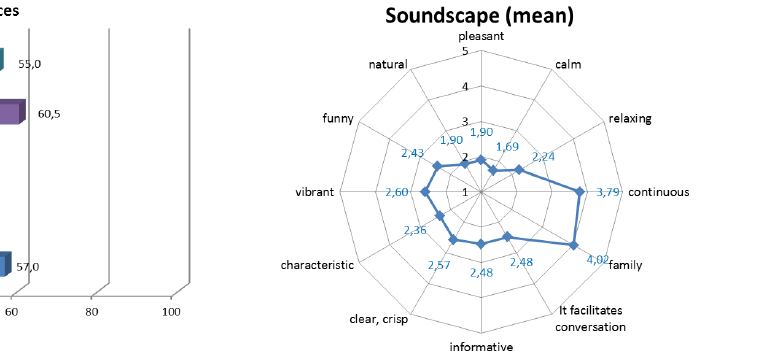
Figure 8: Type of noise sources annotated by participants as dominating during the observation at one location. % of times that the sound source is detected in the different observa- tions in the evaluation point. A total of 41 observations were developed.